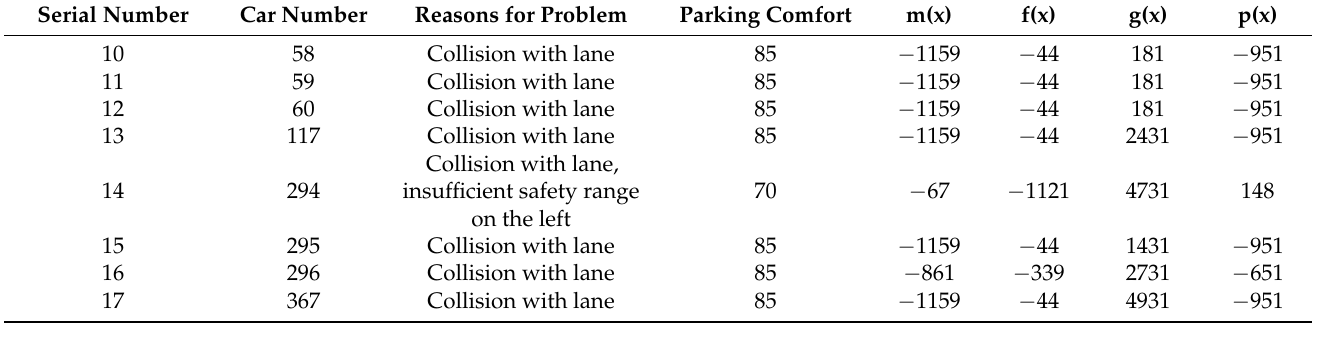
Table 2. Value of the parking space constraint model with poor comfort.